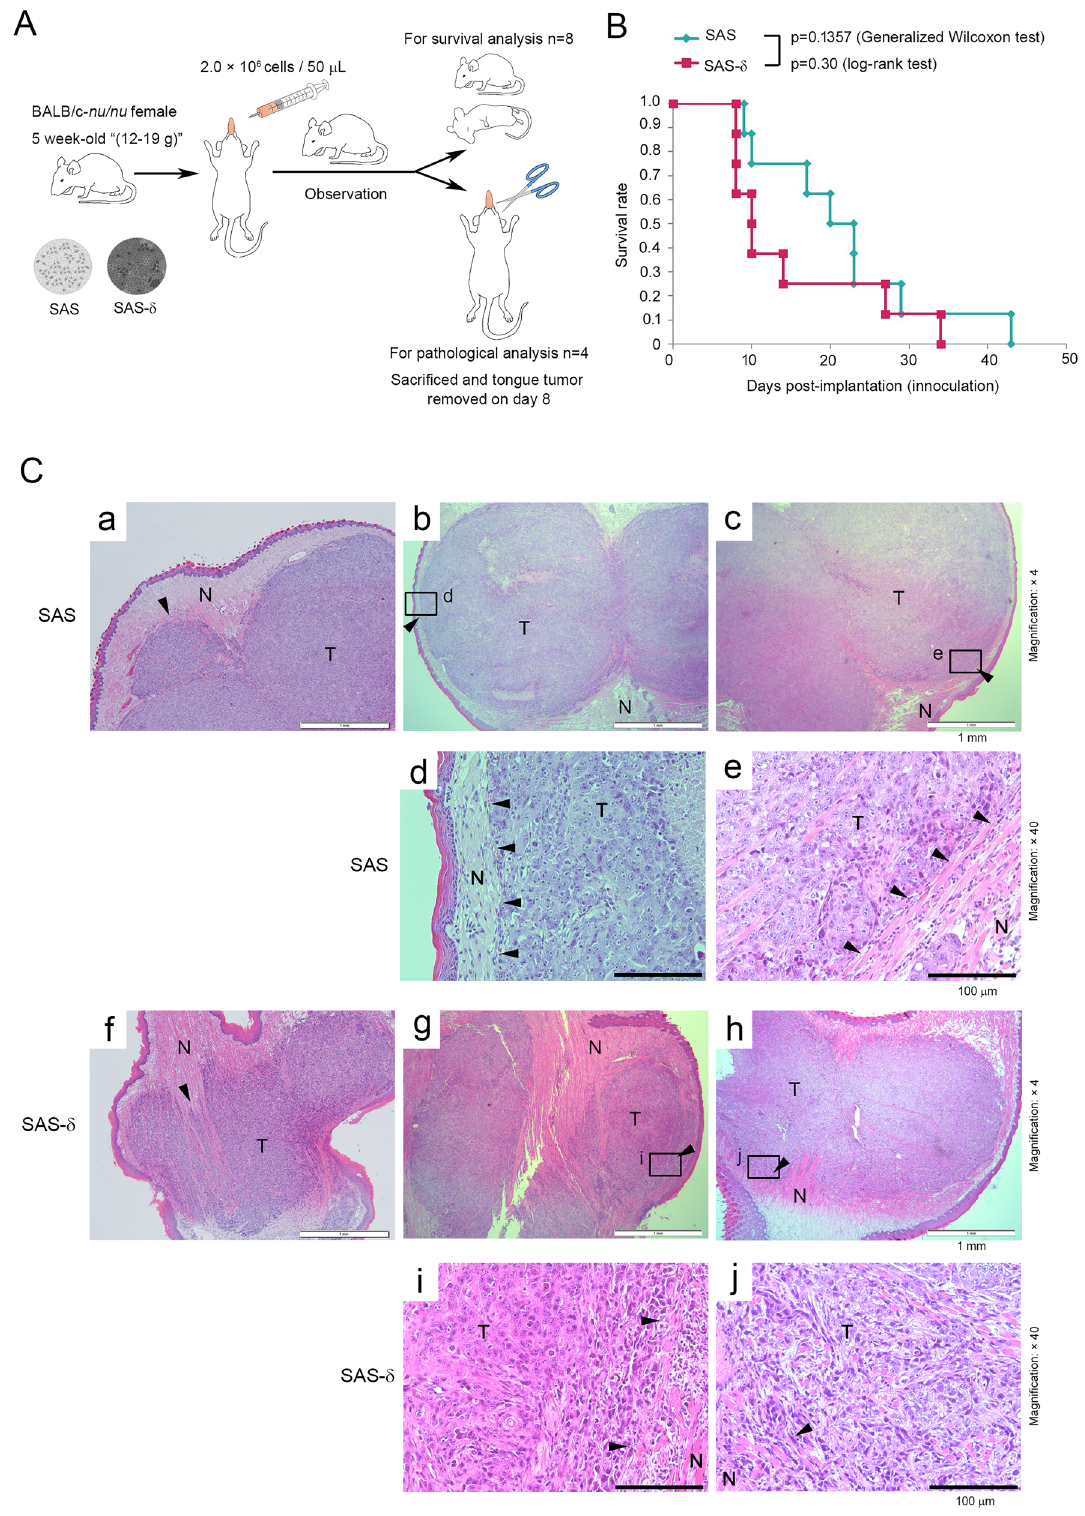
Figure 7. SAS-δ cells enhance in vivo tumorigenicity. ( A ) Schematic drawings of an orthotopic mouse xenograft model of tongue cancer. Parental SAS or SAS-δ cells were injected into the tongue of 5-week-old female nude mice (body weights, 12–19 g; n = 12). These mice were monitored for survival analysis (n = 8) or sacrificed on day 8 for pathological analysis of tongue tumors (n = 4). ( B ) Survival analysis of nude mice injected orthotopically with parental SAS or SAS-δ cells. Survival rates of eight nude mice were evaluated using the Kaplan–Meier method and compared by the generalized Wilcoxon test and log-rank test. ( C ) Representative H&E-stained sections of primary tongue tumors from nude mice injected with parental SAS (a–e) or SAS-δ cells (f–j). Panels d, e, i, and j are high-power fields of areas shown by open boxes in b, c, g, and h, respectively. Arrowheads indicate the boundaries between tumors (T) and normal tissues (N). Scale bars, 1 mm (× 4